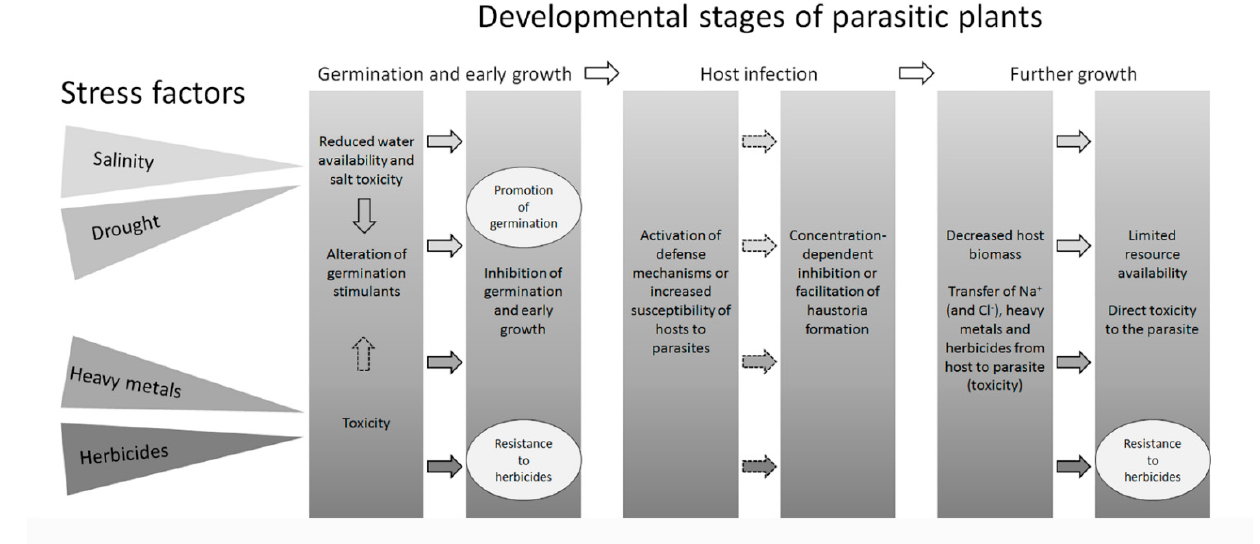
Figure 2. Summary of the effects of abiotic stress factors on different developmental stages of parasitic plants. Main stress factors and their effects are shown in different shading (not reflecting their severity). Dotted arrows depict suggested effects (to be confirmed experimentally). Ellipses denote exceptions to the rule. Furthermore, no reports were found that confirm that heavy metals or herbicides alter the production of strigolactones, but such an effect is not unlikely. No reports on the effects of abiotic stress factors on haustoria formation were found. Topical literature is cited in the text.